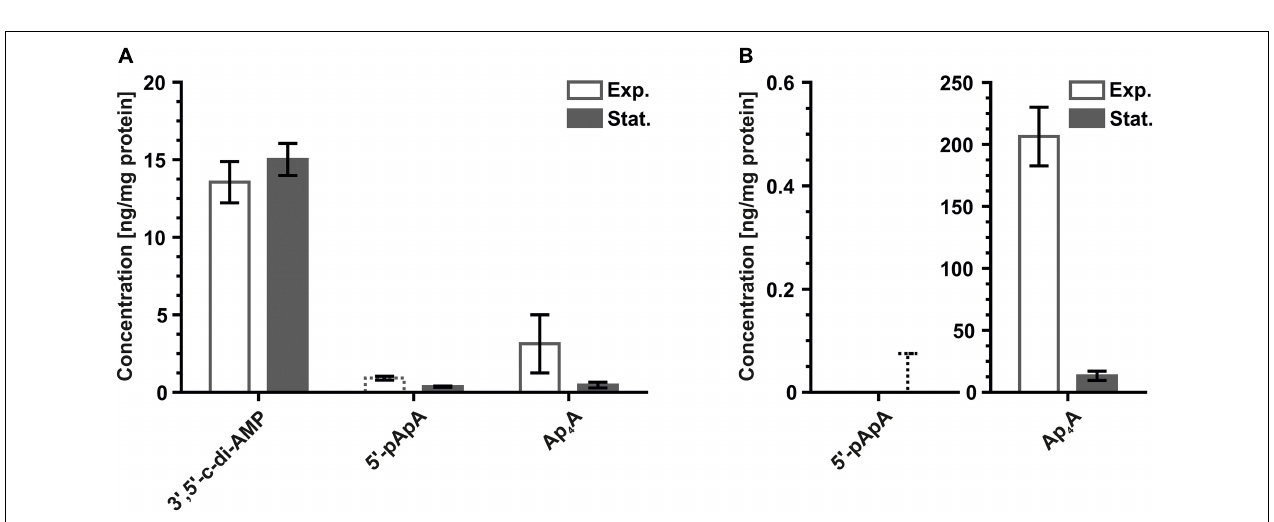
FIGURE 2 | Levels of 2 (cid:48) ,3 (cid:48) -cNMPs detected for exponentially and stationary growing (A) H. volcanii H26 and (B) S. acidocaldarius MW001 cells normalized to the protein content of each sample. Values of regular columns represent the mean of three biological replicates. Error bars of regular columns indicate standard deviation of three biological replicates. Dashed columns indicate presence of one or more technical replicates with measured nucleotide levels below the lowest limit of quantification (LLOQ). Values of dashed columns represent the mean of all technical replicates with nucleotide levels ≥ LLOQ. Error bars of dashed columns indicate standard deviation of all technical replicates with nucleotide levels ≥ LLOQ. The exact nucleotide concentrations are summarized in Table 2 (Exp., exponential; Stat., stationary).